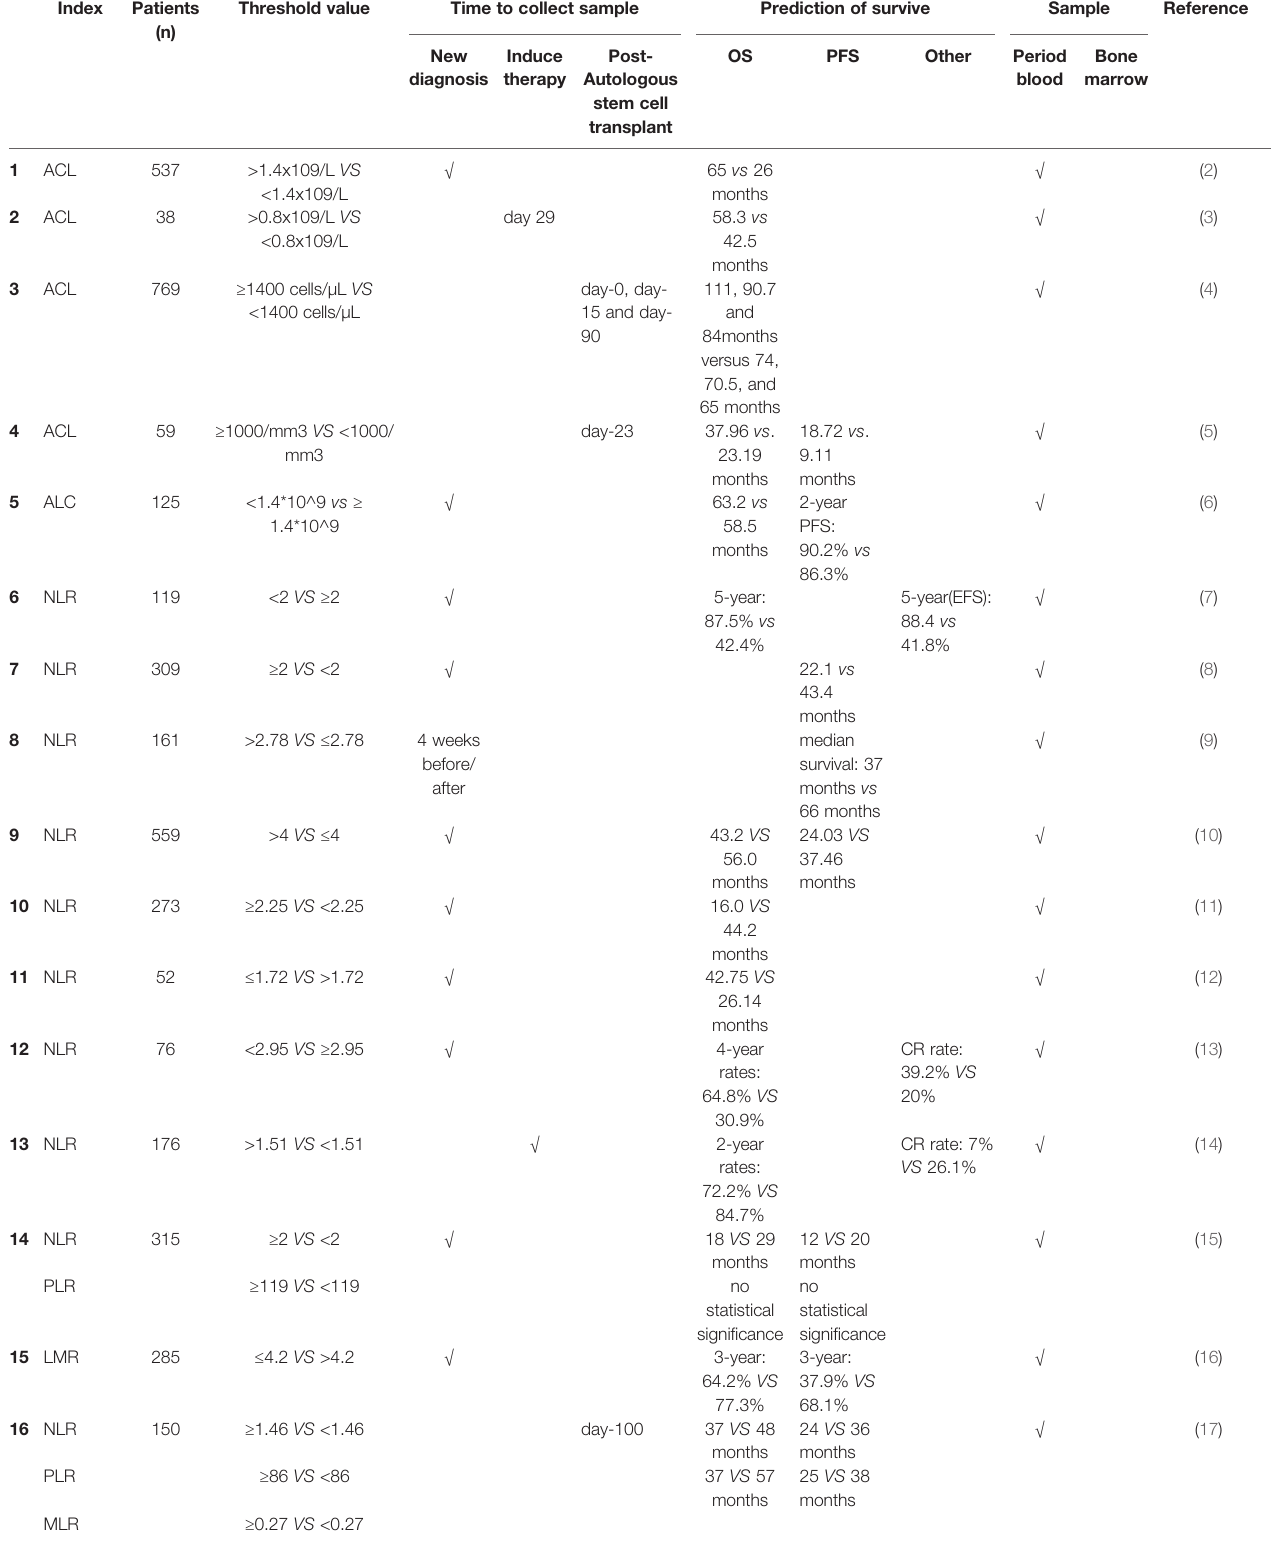
TABLE 1 | Summary of immune pro fi ling in the prediction of survival of patients with multiple